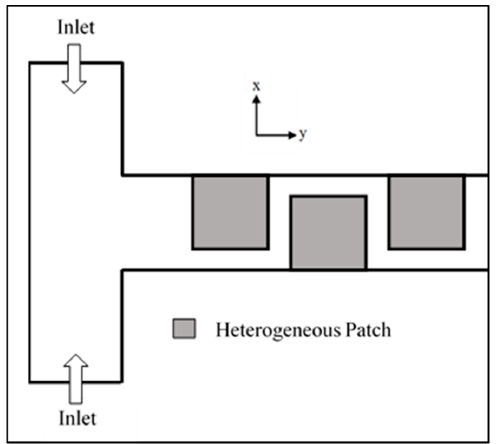
Figure 15. Schematic diagram of the new micromixer design with spacing between adjacent charged patches. Micromachines 2017 , 8 , 199